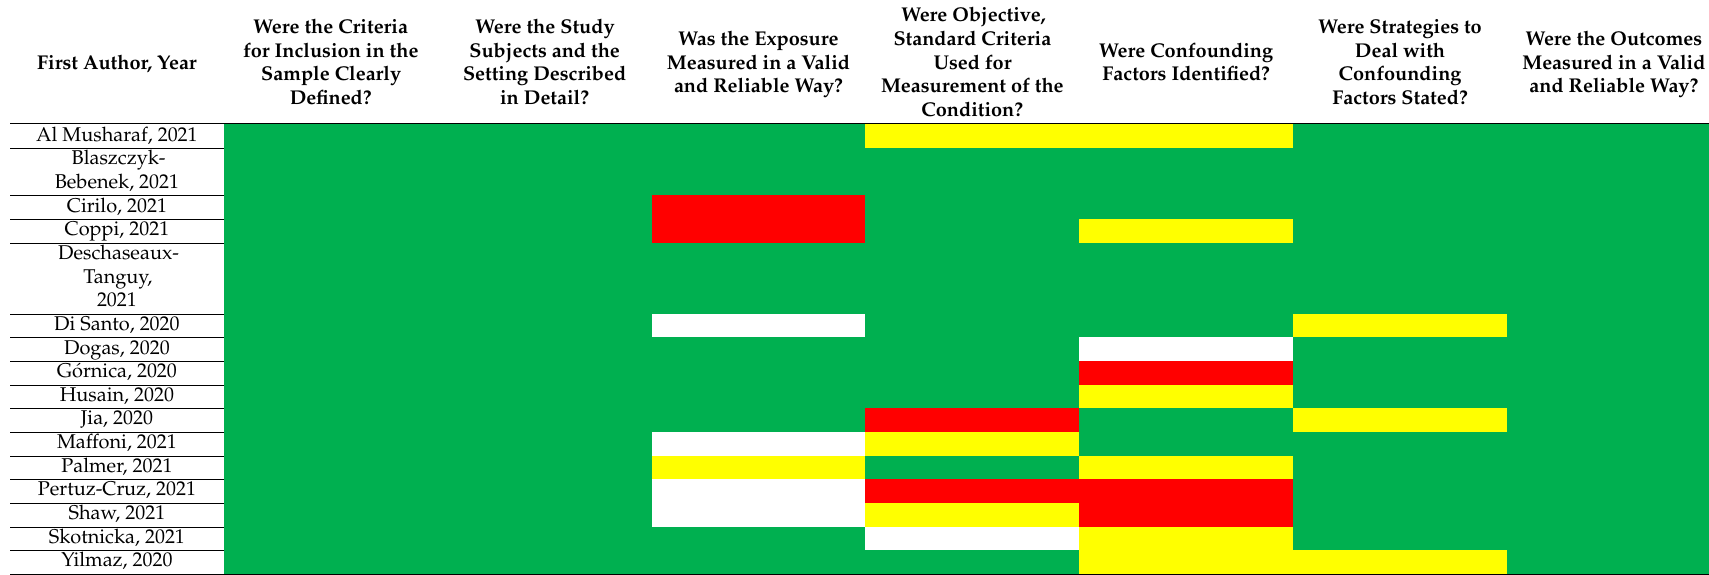
Table 3. Results of the quality assessment of included studies according to the JBI